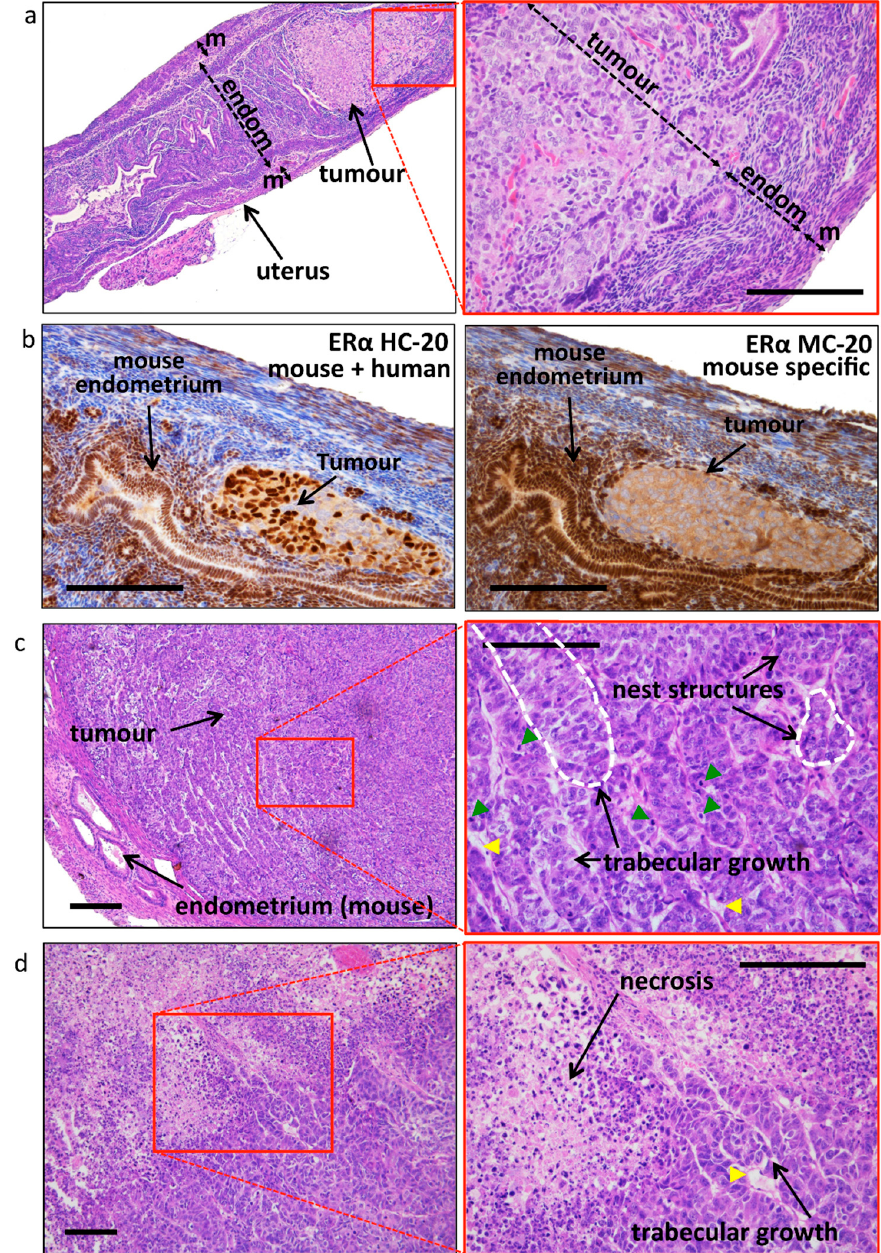
Figure 3. Tumor histology and estrogen receptor expression. ( a ) Representative histology showing the orthotopic location of the induced tumour. The mouse shown is from a placebo treated mouse, where tumour growth remained confined inside the uterus until the end of the experiment. The thickness of the endometrium (endom.) and the myometrium (m) (and the tumour, in the right image only) is indicated by the double-headed arrow. Bar scale: 200 μ m. ( b ) Analysis of ER- α expression using antisera directed against human receptor but cross-reacting with the mouse ER- α (left, HC-20), where both tumour (most likely of human origin) and mouse endometrial tissues have nuclear staining, and using antisera directed against mouse ER- α (right, MC-20), with nuclear staining only in mouse tissues and showing cytoplasmic background in the tumour. Bar scale: 200 μ m. ( c ) Representative image of the tumour histology (E2 treated sample), with nest and trabecular structures (indicated by the dotted white line on the enlargement, right image). Mitotic figures (green arrowheads) and blood vessels (yellow arrowheads) are visible. Bar scale: 200 μ m. ( d ) Representative image of a large tumour with a large necrotic core. Yellow arrowheads: blood vessels. Bar scale: 200 μ m.